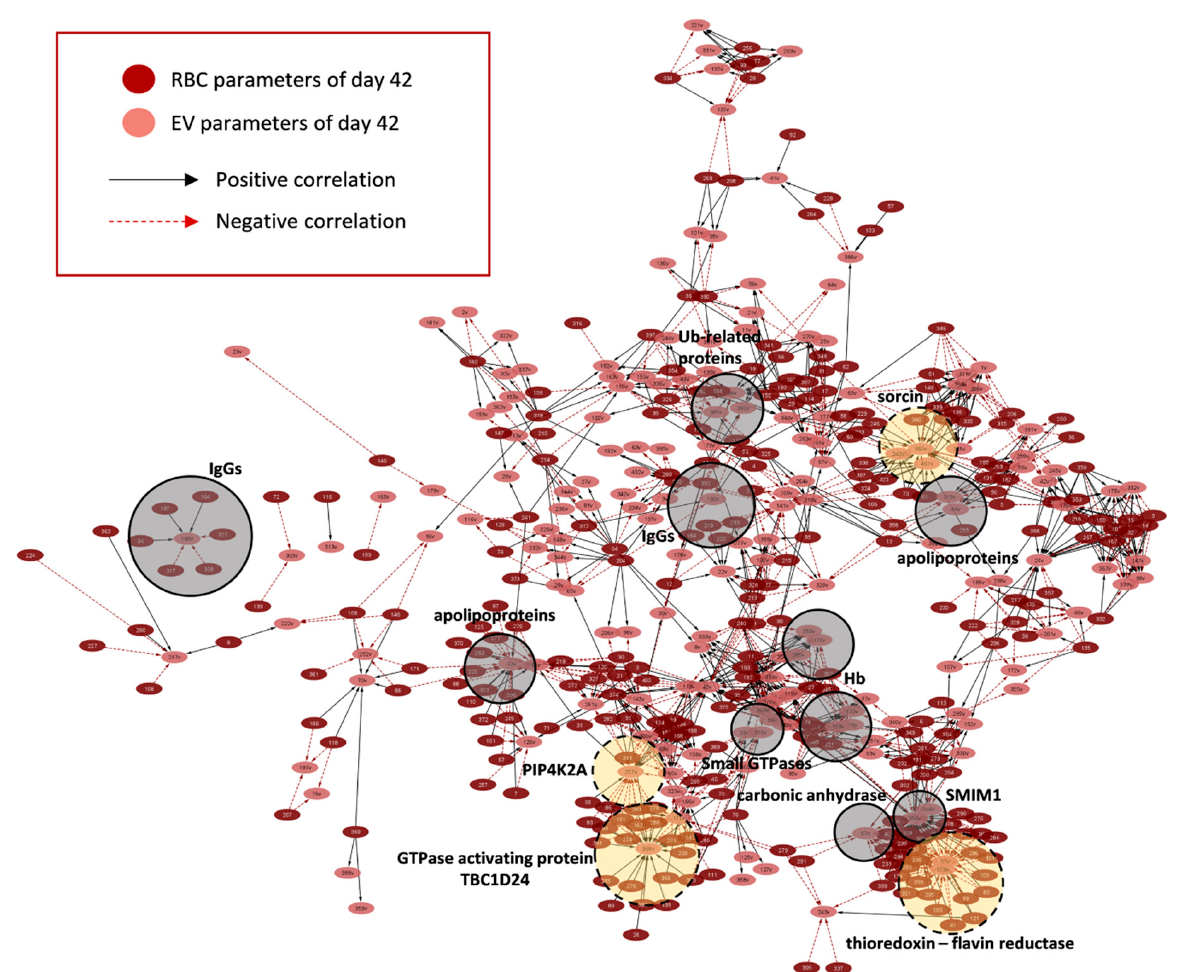
Figure 11. Network connecting RBC to EV parameters in β Thal + RBC units on day 42 of storage. Interactome based on the correlation coefficient R values between parameters of stored RBCs and EVs in late storage. The length of each edge is inversely proportional to the R value (the shorter the edge, the higher the R value). All connections are statistically significant at p < 0.01. Solid light grey circles focus on high connectivity hubs found in both donor groups. Dashed yellow circles highlight representative high connectivity hubs that predominate in the β Thal + network. For abbreviations, see Table S6.